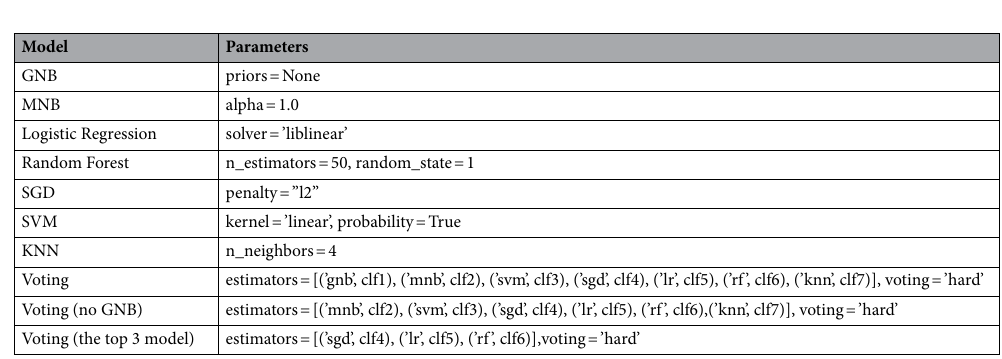
Table 3. Parameter settings to train the classifiers. Abbreviations: GNB, Gaussian naïve Bayes; MNB, multinomial naïve Bayes; SGD, stochastic gradient descent; SVM, support vector machine; KNN,